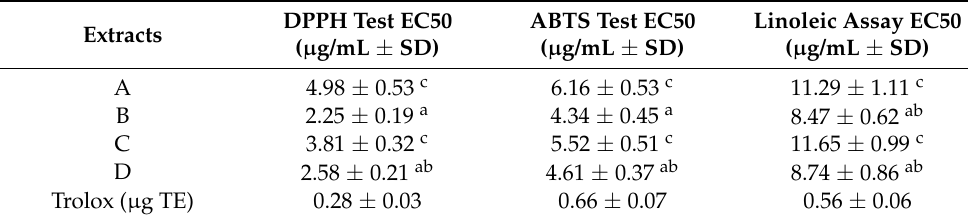
Table 3. Antioxidant properties of the tested extracts.